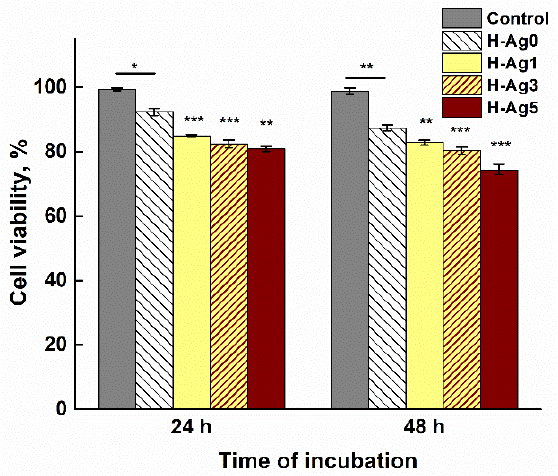
Figure 10. Viability of human dermal fibroblasts cells incubated in the absence (control) and in the presence of hydrogels with different content of silver (* p < 0.05, ** p < 0.01, *** p < 0.001). The cell viability in contact with H-Ag0 hydrogel was around 92% after 24 h and